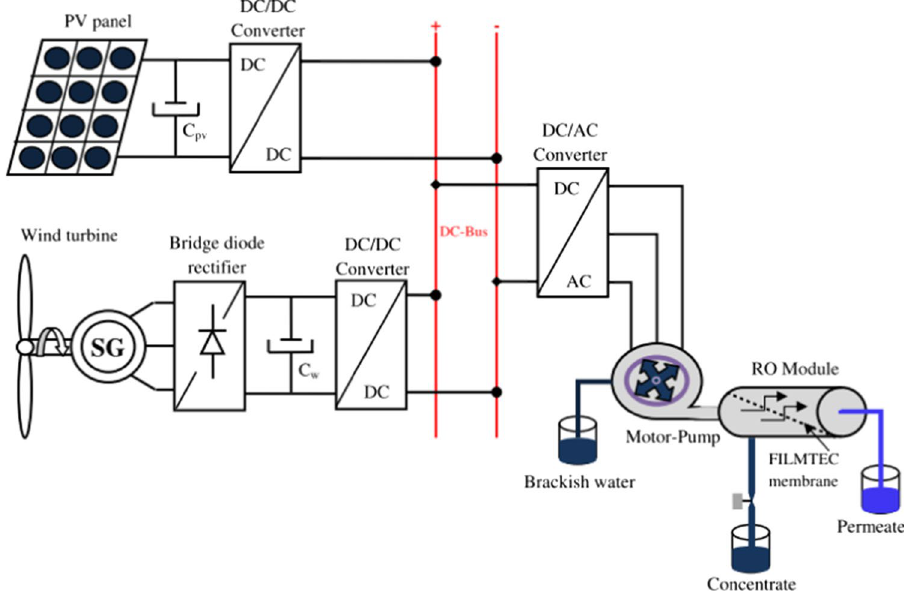
Fig. 36 Producing freshwater by combining wind, PV and RO systems (Nagaraj et al.